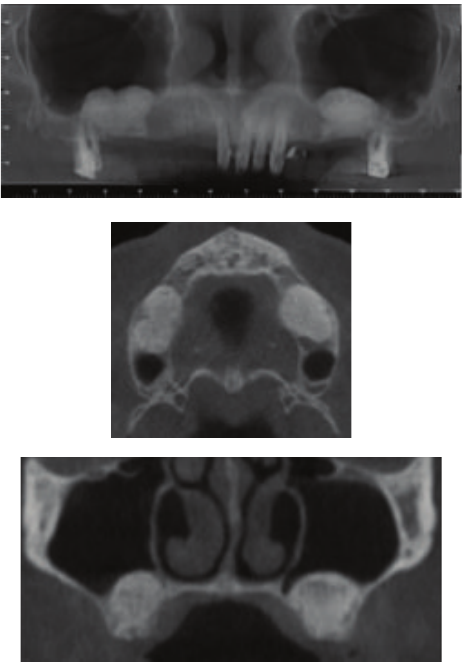
Figure 2: The sinus after the augmentation technique. It is possible to underline the material.